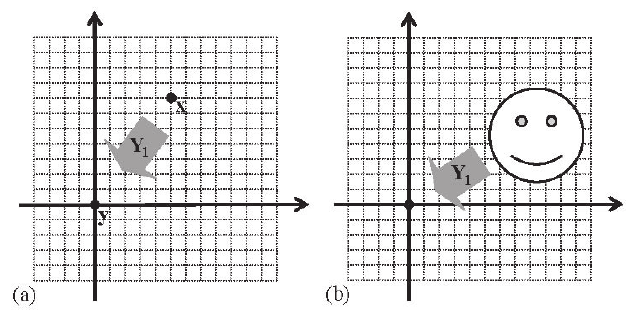
defined by Equation 22. 1